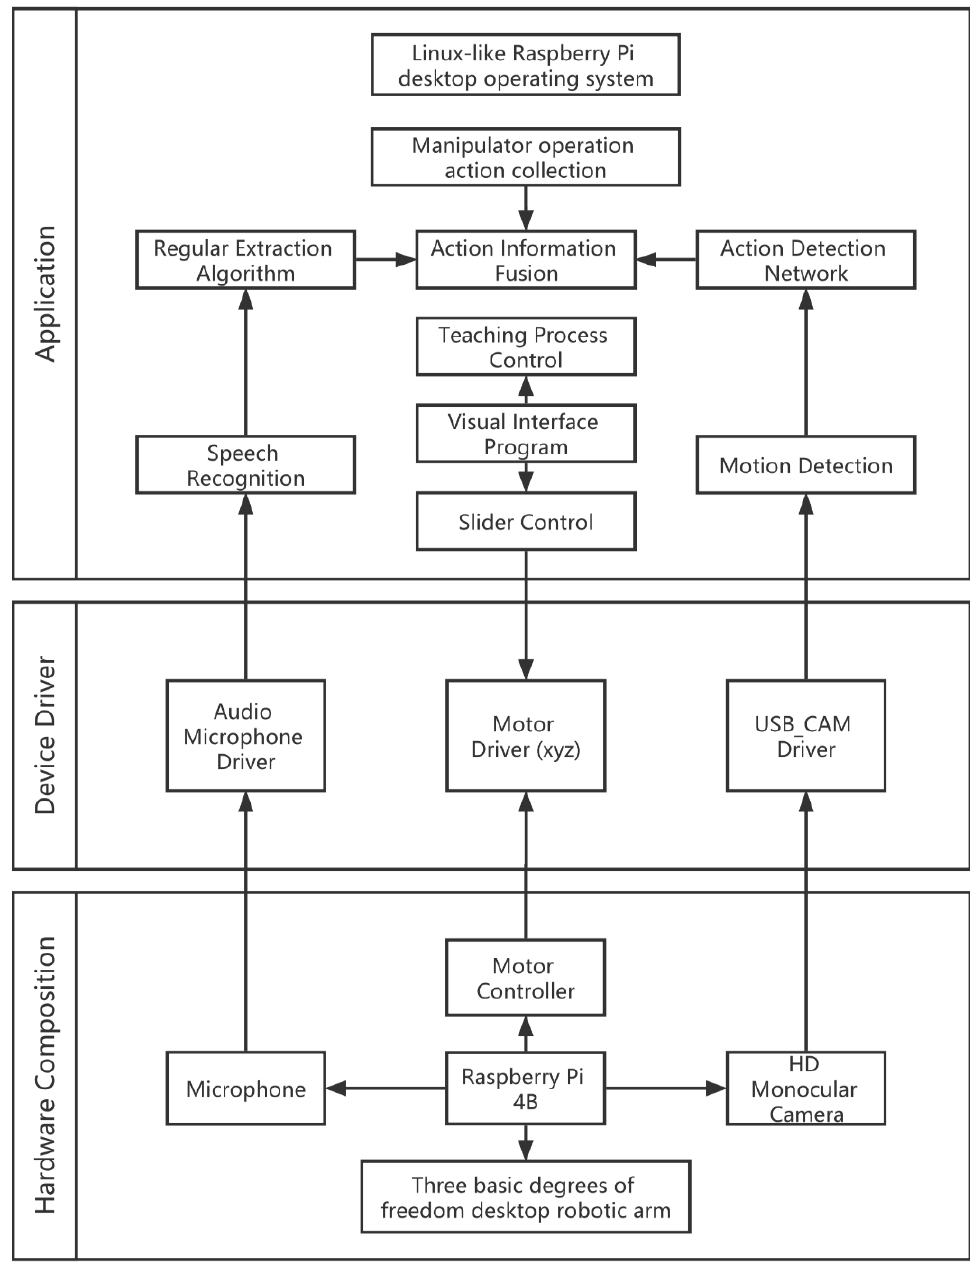
Figure 1. System logical architecture.